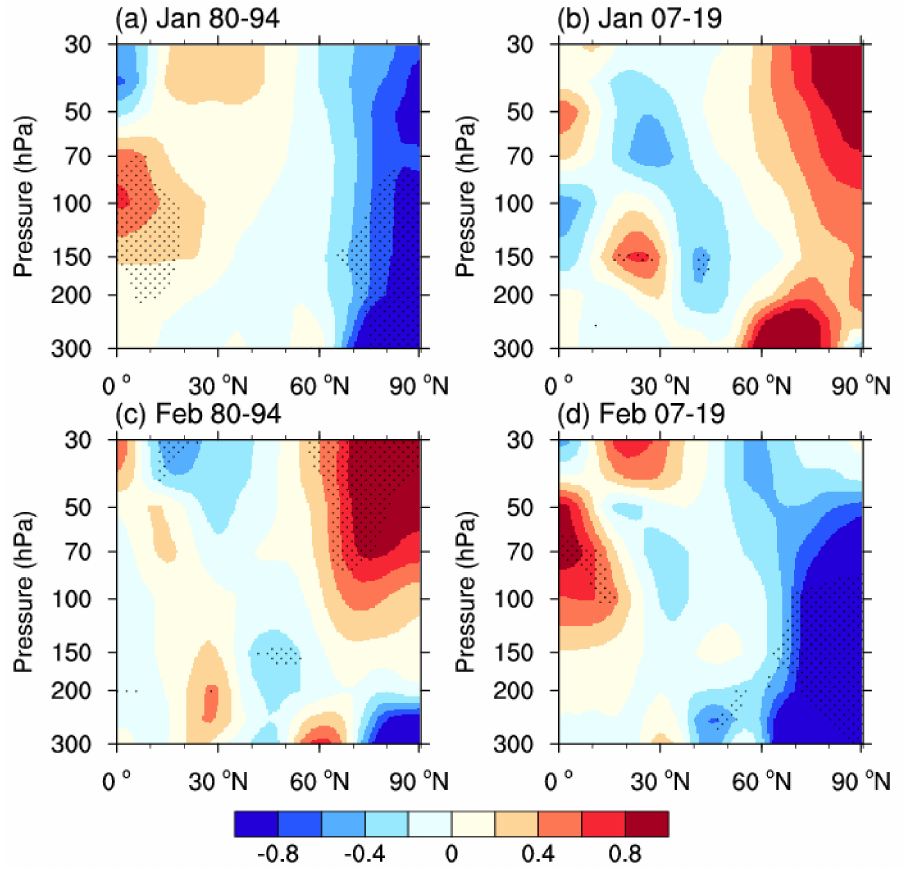
Figure 8. Regression of the buoyancy frequency (s − 2 ) based on the AO index in ( a , b ) January and ( c , d ) February during ( a , c ) 1980–1994 and ( b , d ) 2007–2019. The values over the stippled regions are statistically significant at the 95% confi- dence